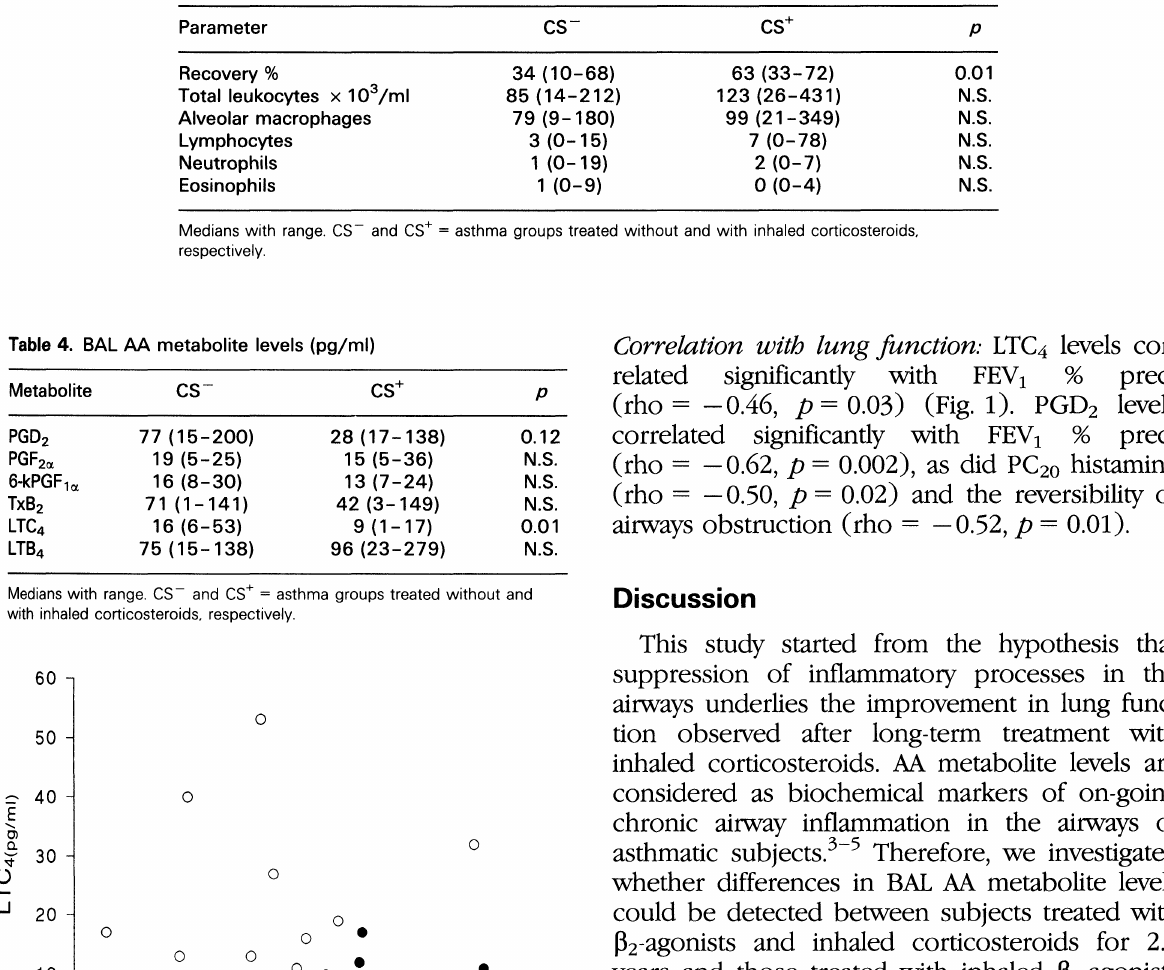
Table 3. Effect of inhaled corticosteroids on BAL fluid volume and cell numbers (pool 2) Parameter